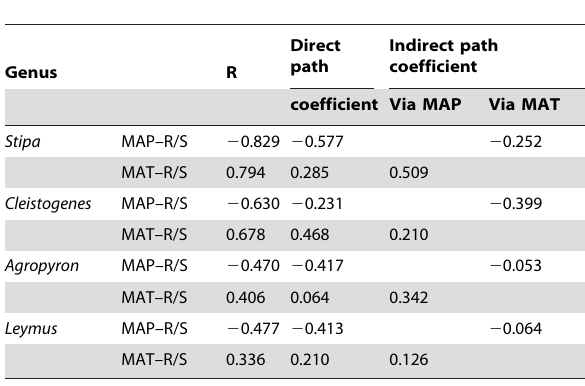
Table 4. Path coefficients between climate factors (MAT and MAP) and plant root/shoot ratios of four dominant genera ( Stipa , Cleistogenes , Agropyron , and Leymus ) across a 2500-km long transect in northern China’s temperature